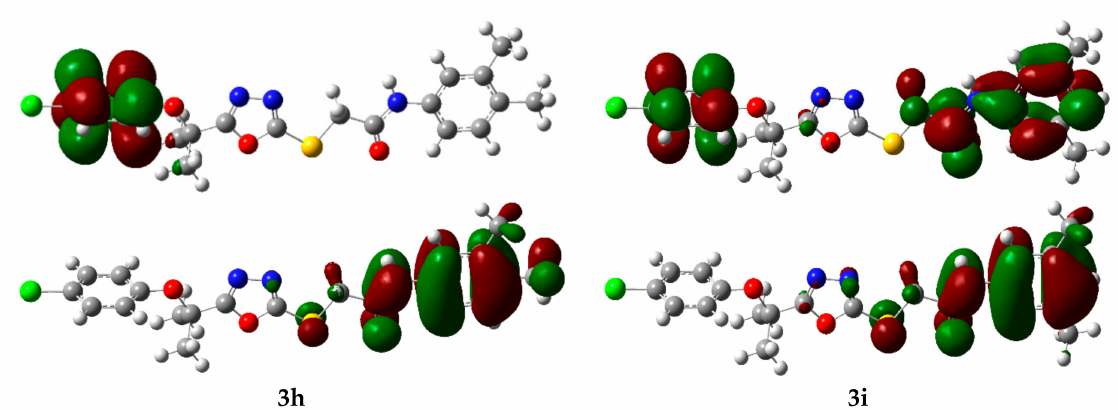
Figure 6. The charge density distribution of the HOMOs (bottom) and LUMOs (top) of the oxadiazoles derivatives ( 3a – 3i and 1 ). Color code of atoms: C—grey, Cl—light green, H—light grey, N—blue, O—red,